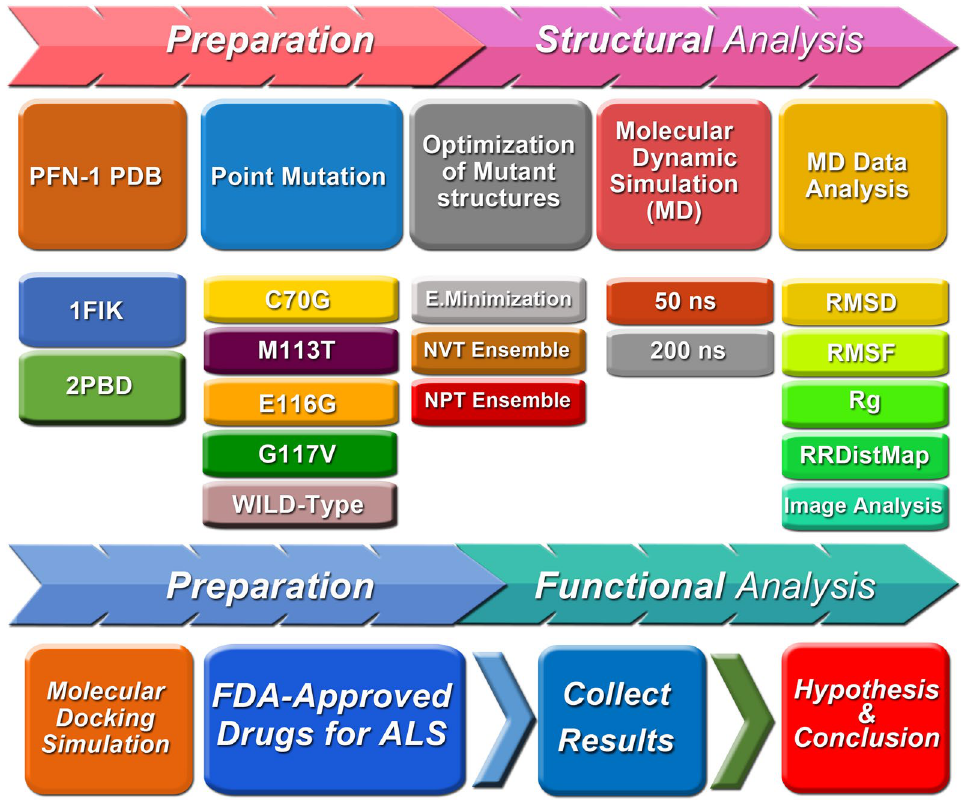
Figure 1. A diagrammatic summary of the preparation, structural and functional analysis of PFN-1. The PDB file of PFN-1 obtained from the protein data-bank, 4 point mutations under the investigation added one at a time, optimized, performed molecular dynamic simulation, and data analysis carried out as outlined in the cartoon format. The lower part of the diagram demonstrates the outline of our work with respect to the effect of the two FDA approved drugs for